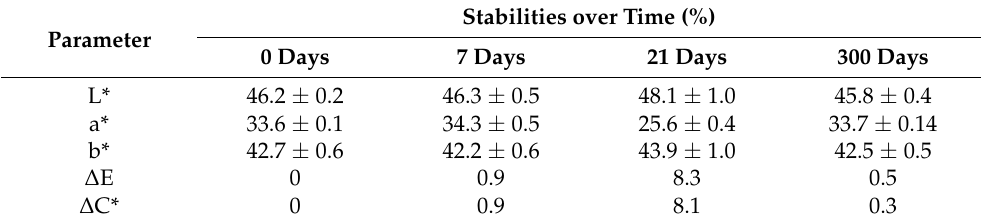
Table 5. Colour stability parameters (L*, a*, and b*), cumulative difference in colour ( ∆ E), and cumu- lative difference in colour intensity ( ∆ C*) of lutein esters in the PSM and MCT oil fine suspensions (formulation 2LE).